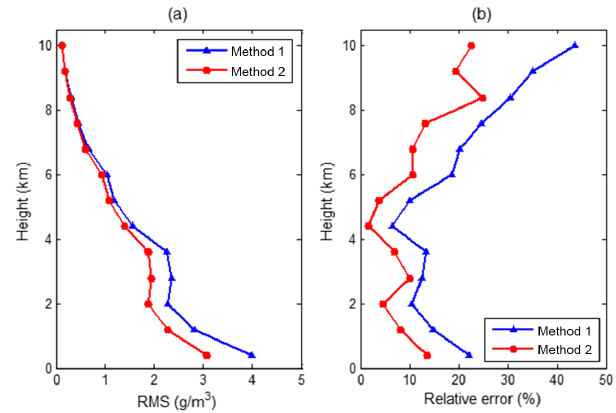
Figure 13. RMS and relative error change with heights (blue curve and red curve are derived from the differences between the profiles of method 1, method 2 and radiosonde, separately for 62 epochs spanning from 1 to 31 May 2015.